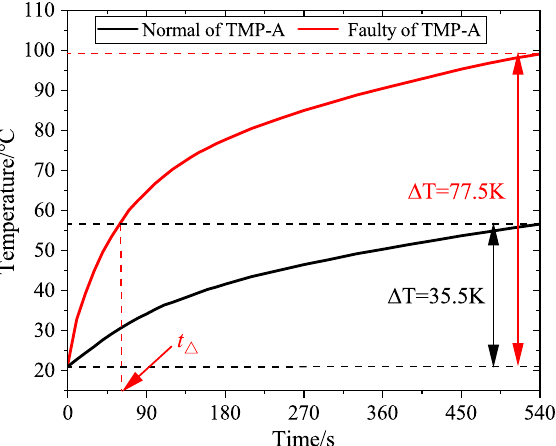
Figure 10. Measured TR curve at TMP-A in the first nine